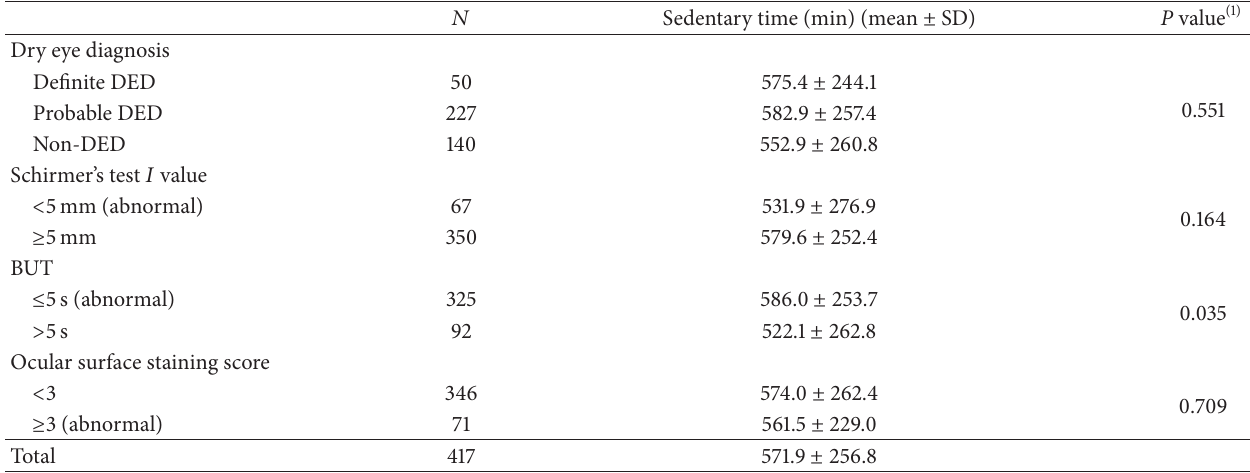
Table 4: Sedentary behavior, DED diagnosis, and clinical parameters. 𝑁 Sedentary time (min) (mean ± SD) P value